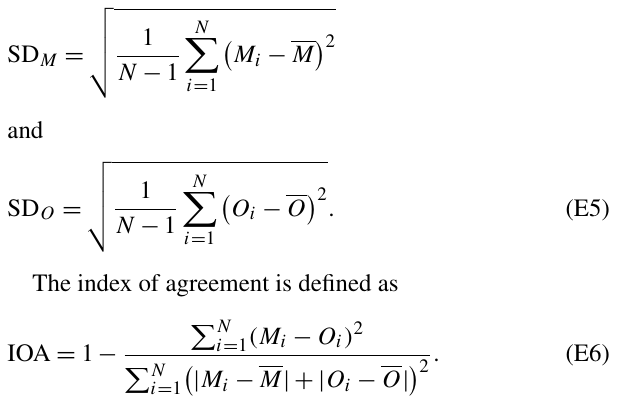
sure and is defined